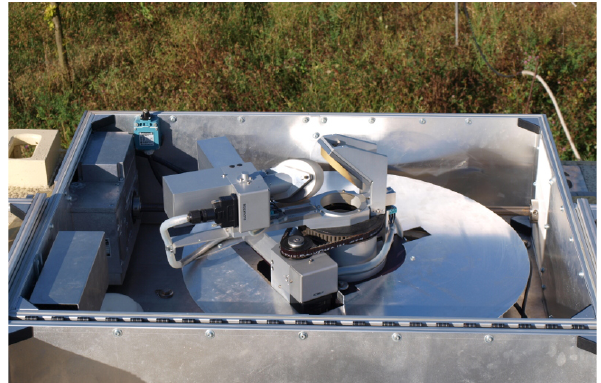
Fig. 3. The Bruker Solar Tracker type A547 mounted in the custom made dome (shown in open state).